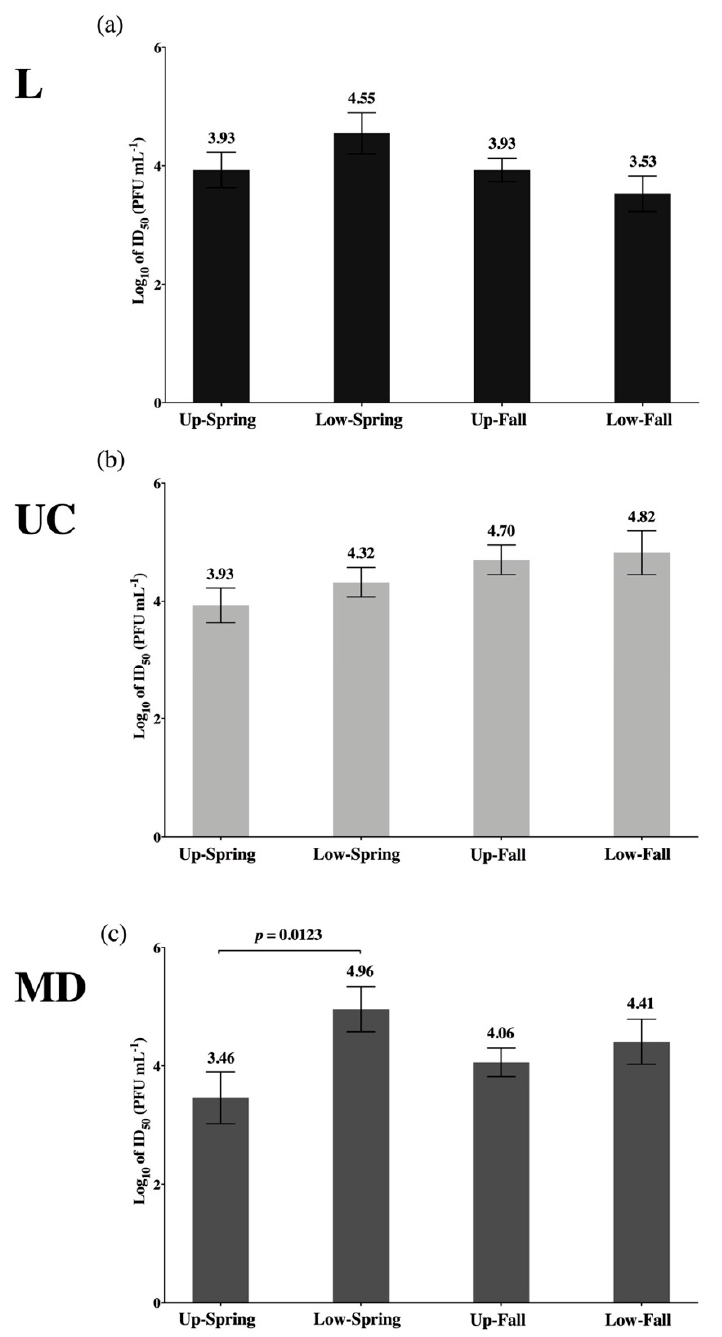
Figure 6. Comparison of ID 50 values generated for the L (FR0031), UC (RB1), and MD (QTS07) strains of IHNV included in this investigation. ID 50 values for the L-( a ), UC-( b ), and MD-IHNV ( c ) strains were assessed for differences in infectivity relative to the experimental host population. Multiple pairwise comparisons of ID 50 (log 10 PFU mL − 1 , ± SE) for spring-run (Spring) and fall-run (Fall) O. tshawytscha of the upper (Up) and lower (Low) Columbia River were performed. Significant differences between ID 50 values are reported as Welch–Satterthwaite 2-tailed t -test p values. To account for multiple pairwise comparisons, the 0.05 significance level was Bonferroni-corrected to α = 0.0083.